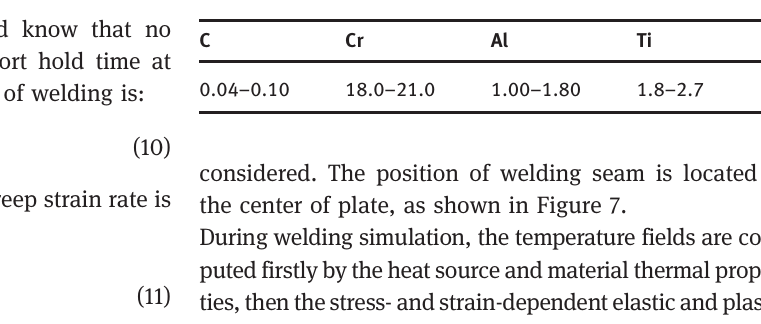
Table 1: Chemical compositions of GH80A (mass.